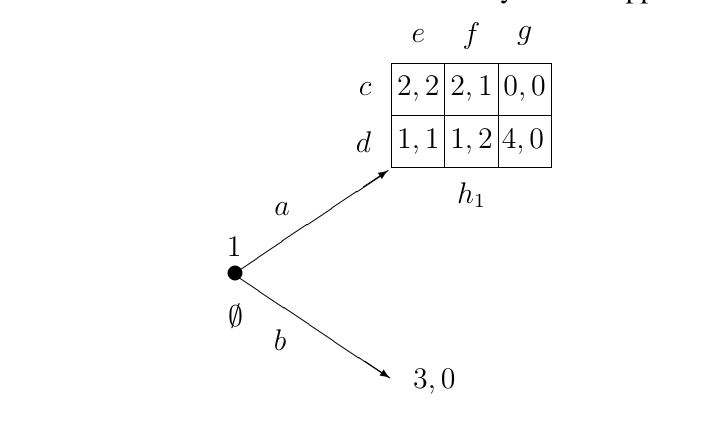
Figure 1. Backwards induction and forward induction may lead to opposite